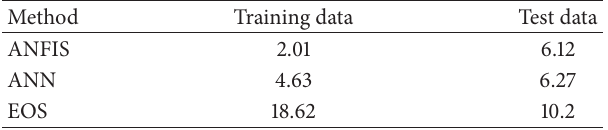
Table 4: Average relative error (%) between simulated results obtained by different methods and experimental data.